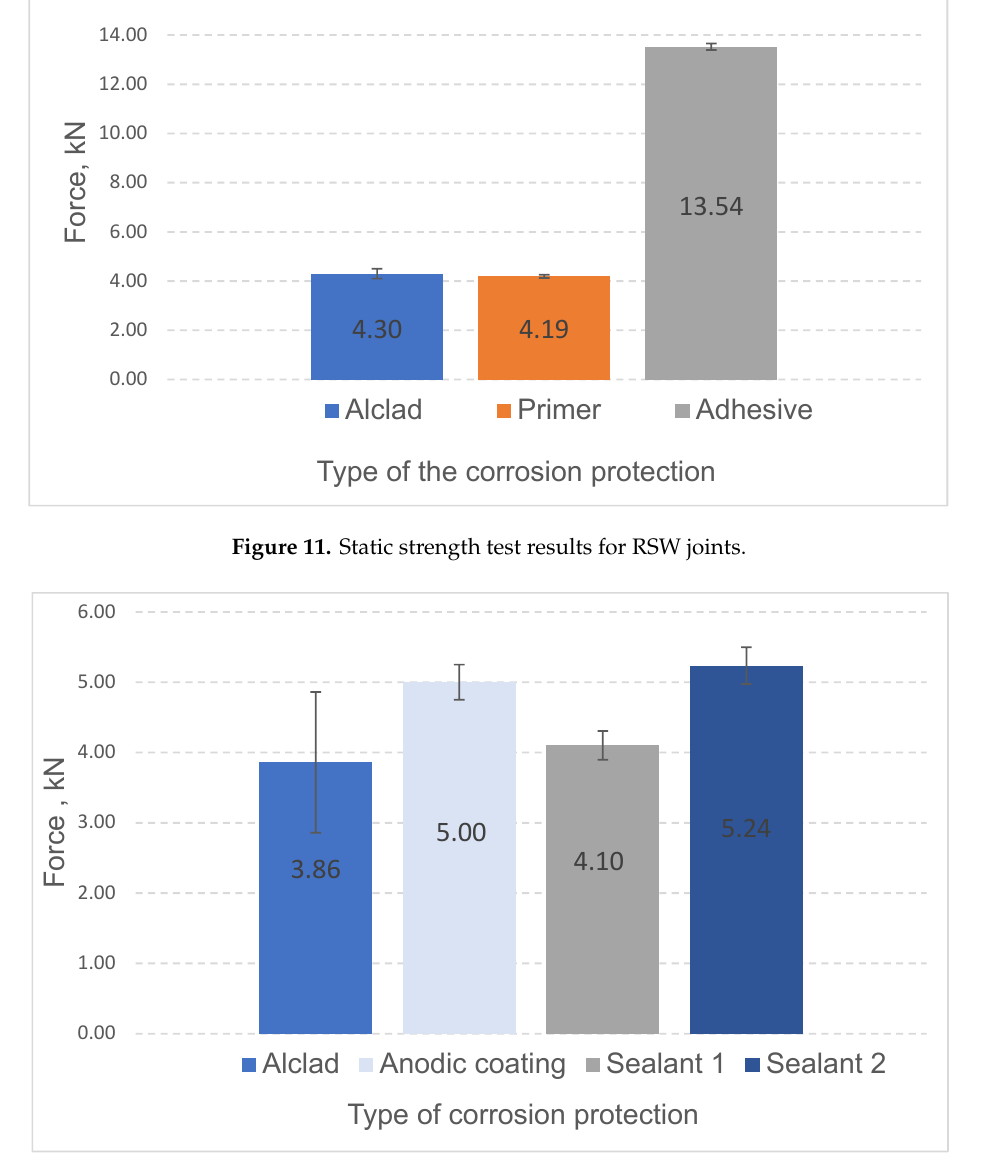
Figure 12. Static strength test results for RFSSW joints .